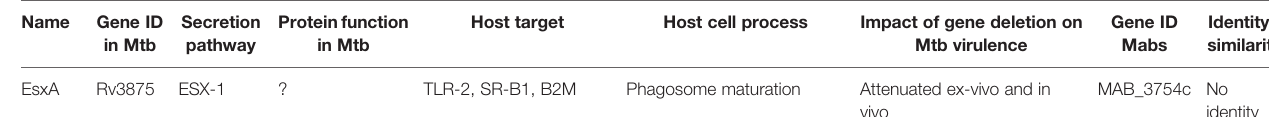
TABLE 1 | Secreted effectors in M. tuberculosis , and their putative analogs in M. abscessus